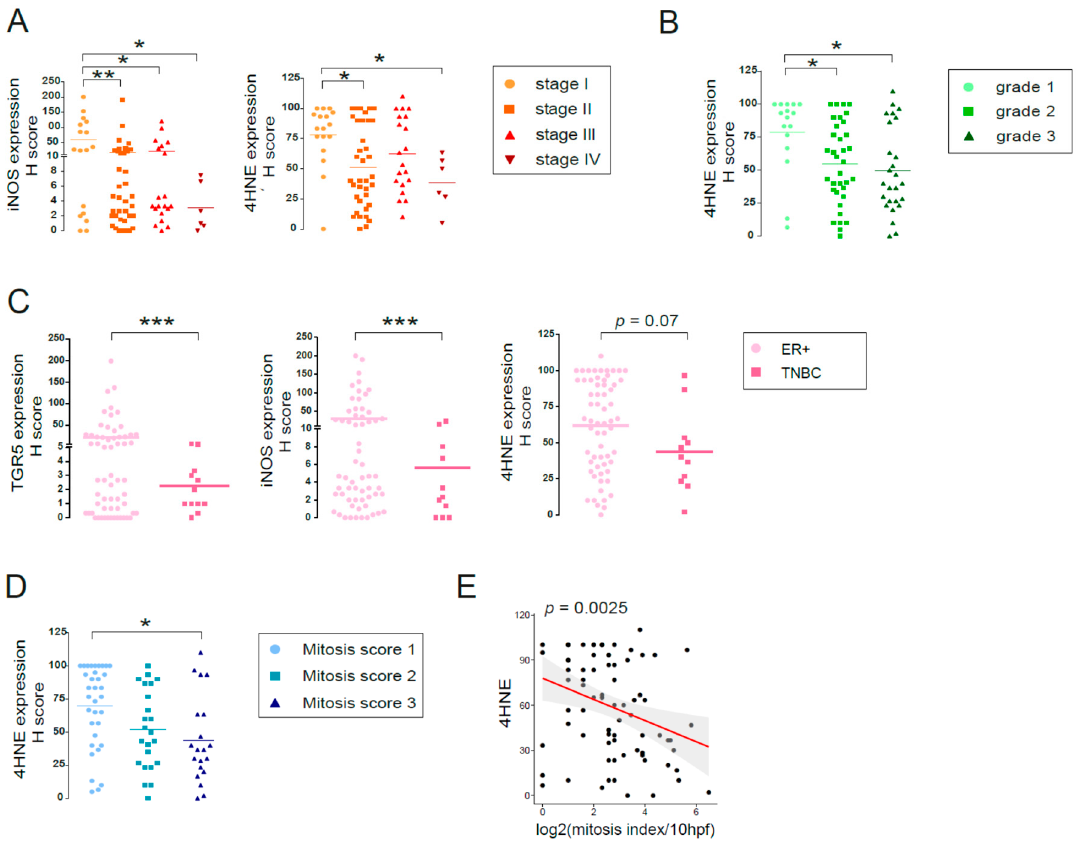
Figure 12. LCA-induced oxidative stress pathway is protective in human breast cancer. ( A – D ) The expression levels of oxidative/nitrosative stress markers were analyzed in tumor samples of 88 breast cancer patients using tissue microarray (TMA), as indicated on the graphs. ( A ) Patients were stratified based on disease stage (Stage I–IV), ( B ) pathological grade of the disease (Grade 1–3), ( C ) ER+ vs. TNBC cases, and ( D ) mitosis score (mitosis score 1–3), and the expression level of indicated markers were determined using IHC analysis. ( E ) Linear regression analyses for the correlation between 4HNE expression levels and the mitotic index were determined using R project. TGR5: Pearson r = − 0.13; p = 0.26; iNOS: Pearson r = − 0.16; p = 0.16; 4HNE: Pearson r = − 0.34; p = 0.0025. Line represents linear regression of data (TGR5: y = 25 − 3x; iNOS: y = 38 − 4.7x; 4HNE: y = 78 − 7x). *, **, and *** indicate p < 0.05, p < 0.01 or p < 0.001, differences between patient groups. (TGR5/GPBAR1, G protein-coupled bile acid receptor 1/Takeda G-protein coupled receptor; 4HNE, 4-hydroxynonenal).